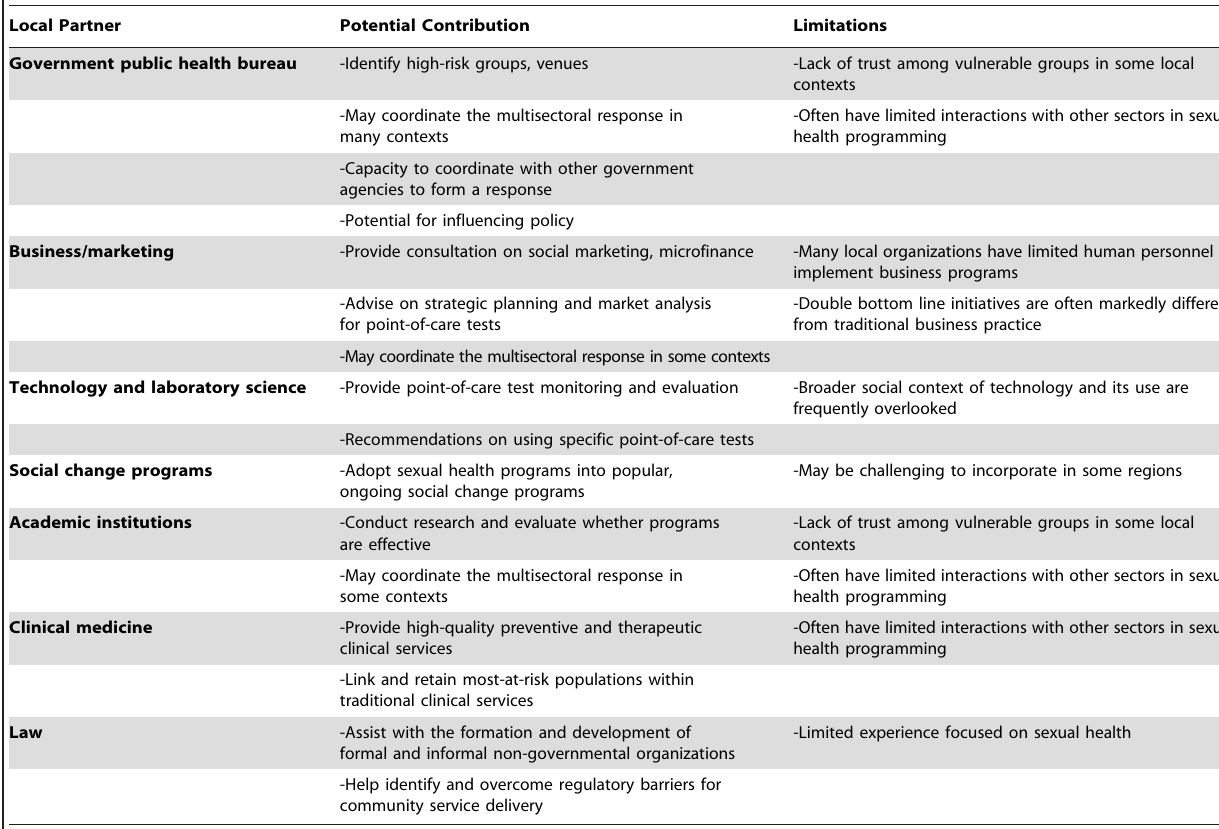
Table 2. Key partners in a multisectoral SESH